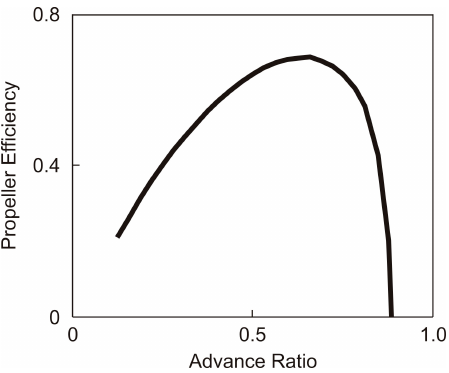
Figure 8. Propeller efficiency of a small-scale propeller (reproduced in part from [26], propeller diameter: 0.2286 m).